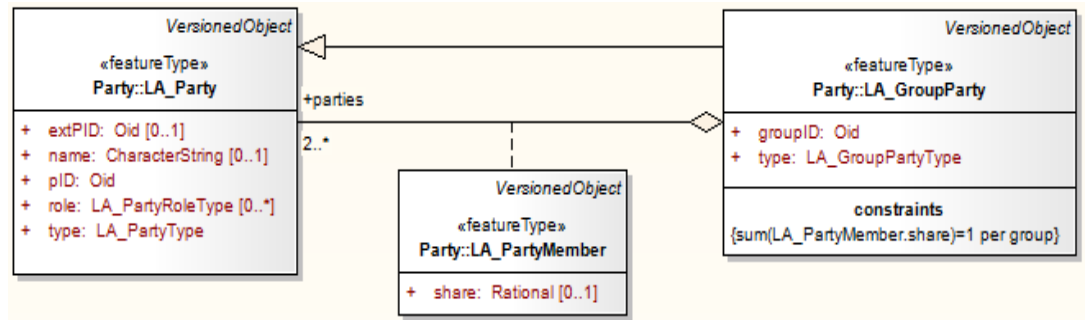
Figure 3. Party package classes (ISO,